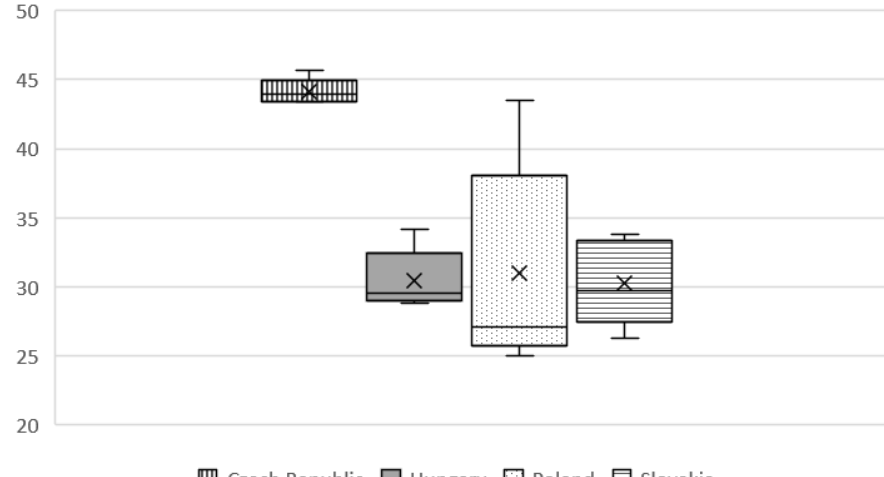
F IGURE 1. B OX PLOT DIAGRAM FOR VARIABLE : P ERCENTAGE OF MEDIUM - SIZED ENTERPRISES PROVIDING TRAINING TO THEIR PERSONNEL TO DEVELOP THEIR ICT